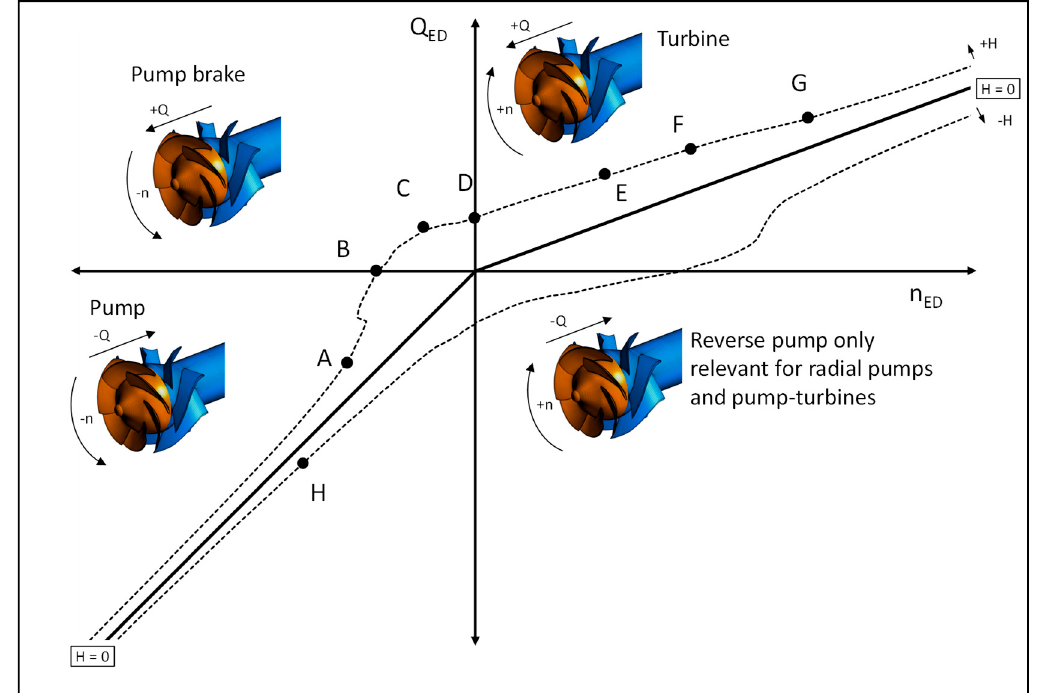
Figure 1. Extended operating range of a semi-axial pump according to the IEC 60193 standard.